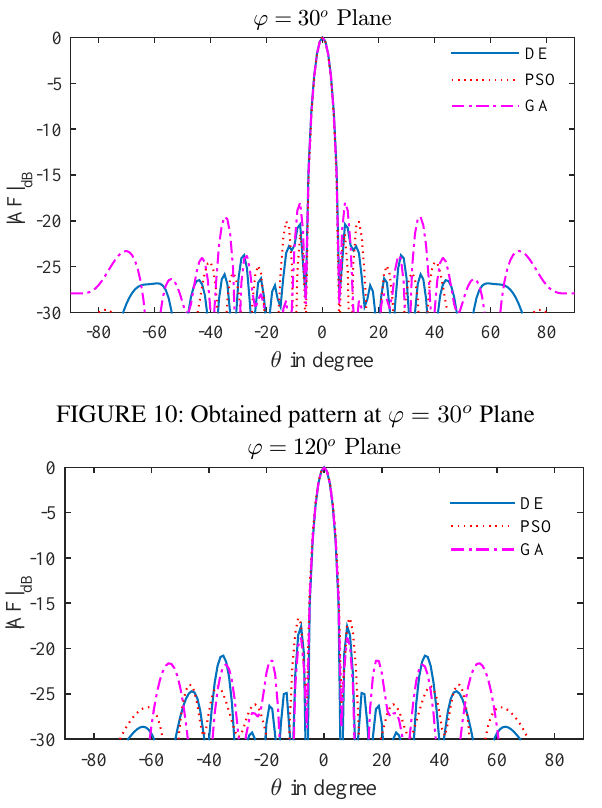
FIGURE 10: Obtained pattern at ϕ = 30 o Plane